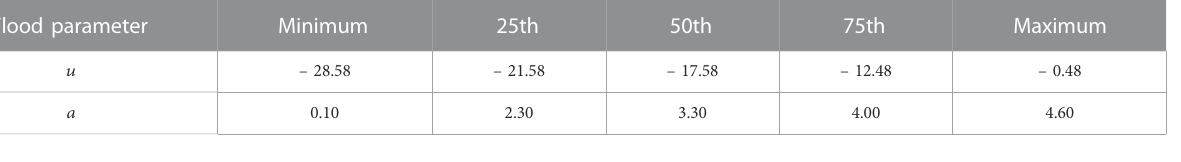
TABLE 1 Descriptive statistics for synthetic fl ood parameters in the shaded X Zone. Flood parameter Minimum